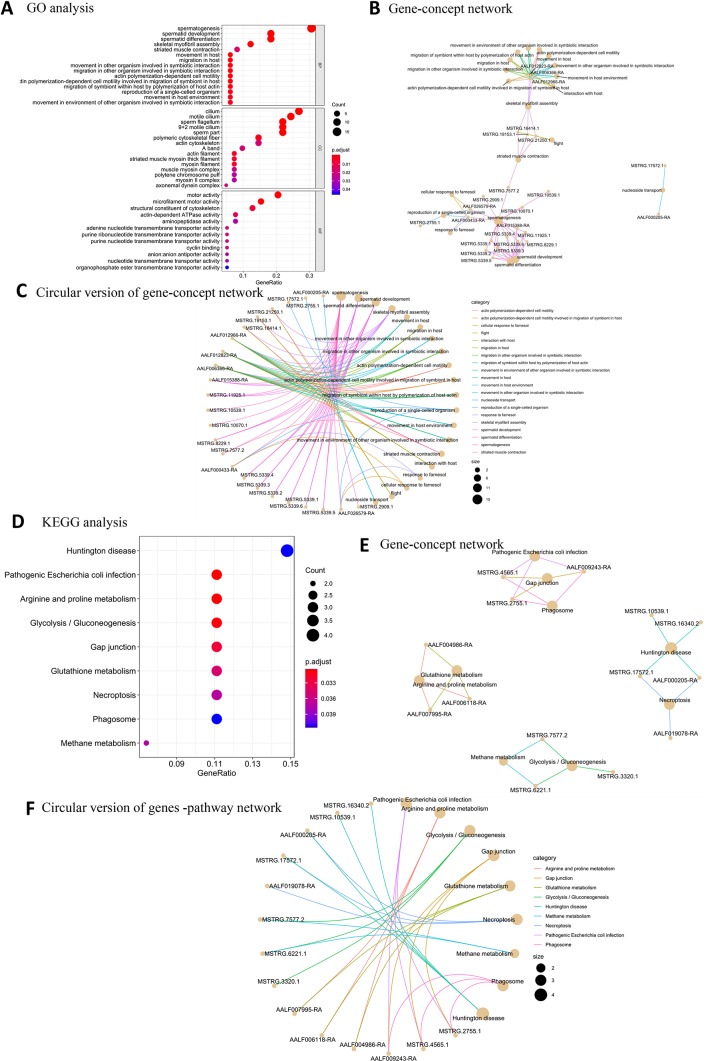
GO and KEGG pathway enrichment analysis of male high-expression protein-coding genes. (A) The top 20 GO terms for BP, CC, and MF for male high-expression protein-coding genes. (B) Gene-concept network depicting the linkages of male high-expression protein-coding genes and biological concepts as a network. (C) Circular version of gene-concept network for male high-expression protein-coding genes. (D) Top KEGG pathway terms for male high-expression protein-coding genes. (E) Protein-coding gene-pathway network depicting the linkages of male high-expression protein-coding genes and KEGG pathways as a network. (F) Circular version of male high-expression protein-coding gene-pathway network.